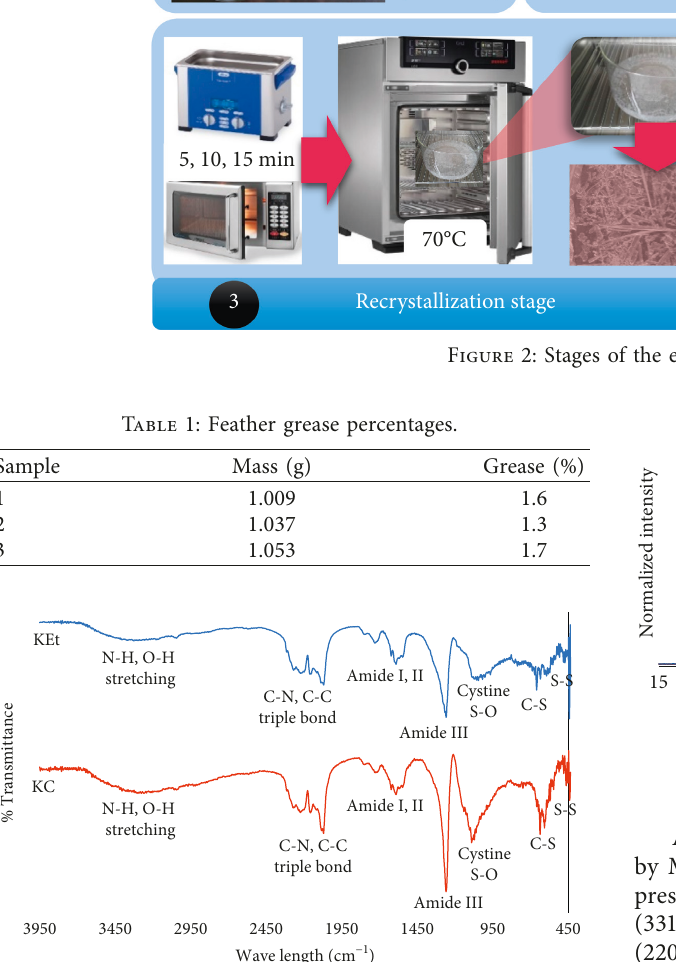
Figure 3: FTIR spectra of the KC and KEt samples.